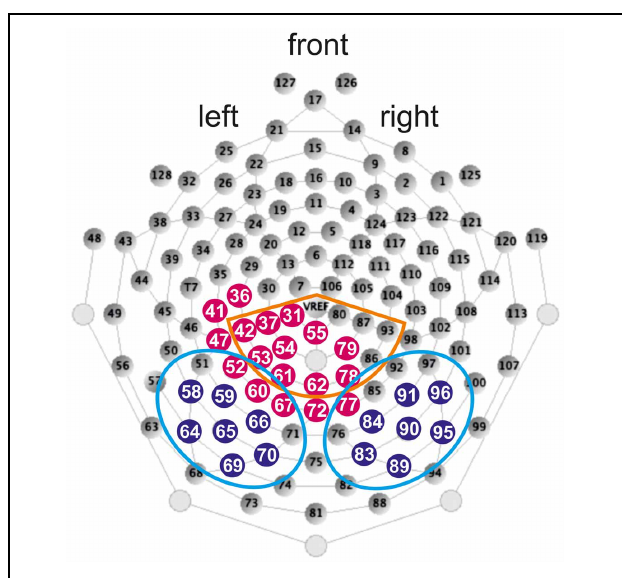
FIGURE 2 | Illustration of the 128-channel-system and electrode position taken from Electrical Geodesics Inc. (2007). Filled blue dots depict electrodes included in the LH and RH ROIs of the N170. Light blue circles depict electrodes included in the LH and RH ROIs of the N170 difference waves. Orange circle depicts electrodes included in the ROI of the N400 and filled red dots depict electrodes included in the ROI of the